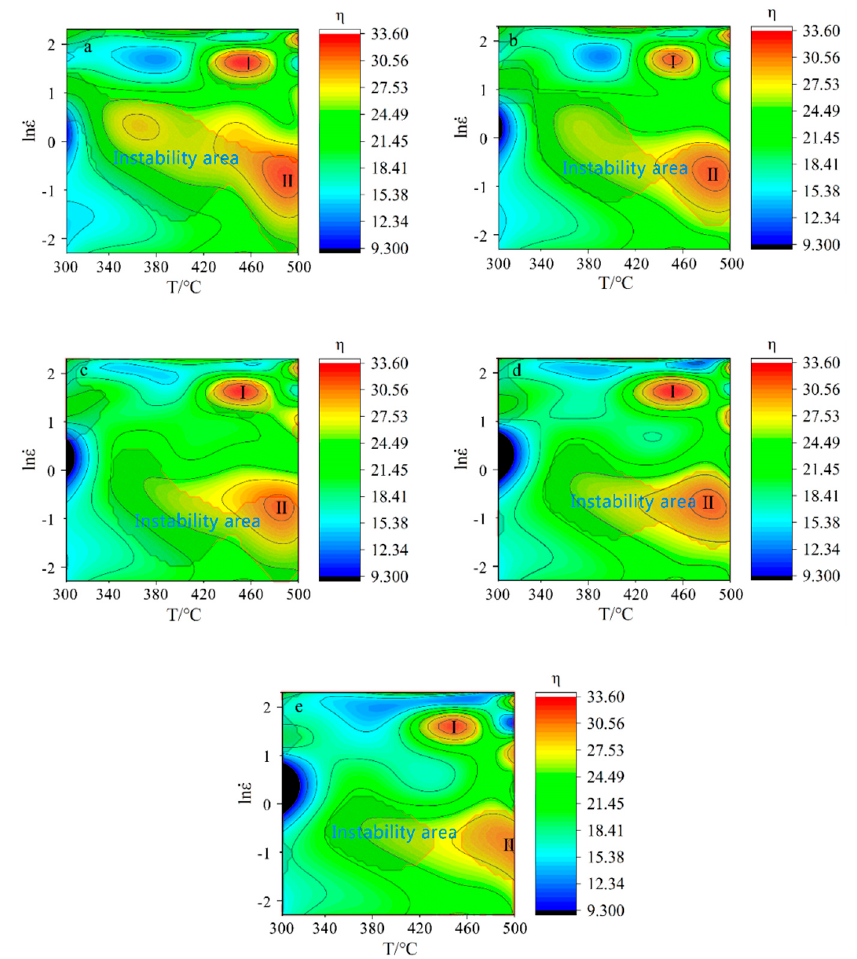
Figure 15. The processing map under different strain conditions: ( a ) ε = 0.15; ( b ) ε = 0.25; ( c ) ε = 0.35; ( d ) ε = 0.45; ( e ) ε = 0.55.